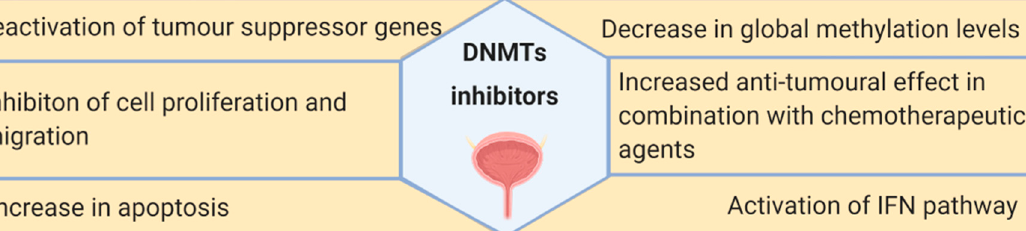
Figure S1. Chemical structure of nucleoside and non-nucleosides DNMT